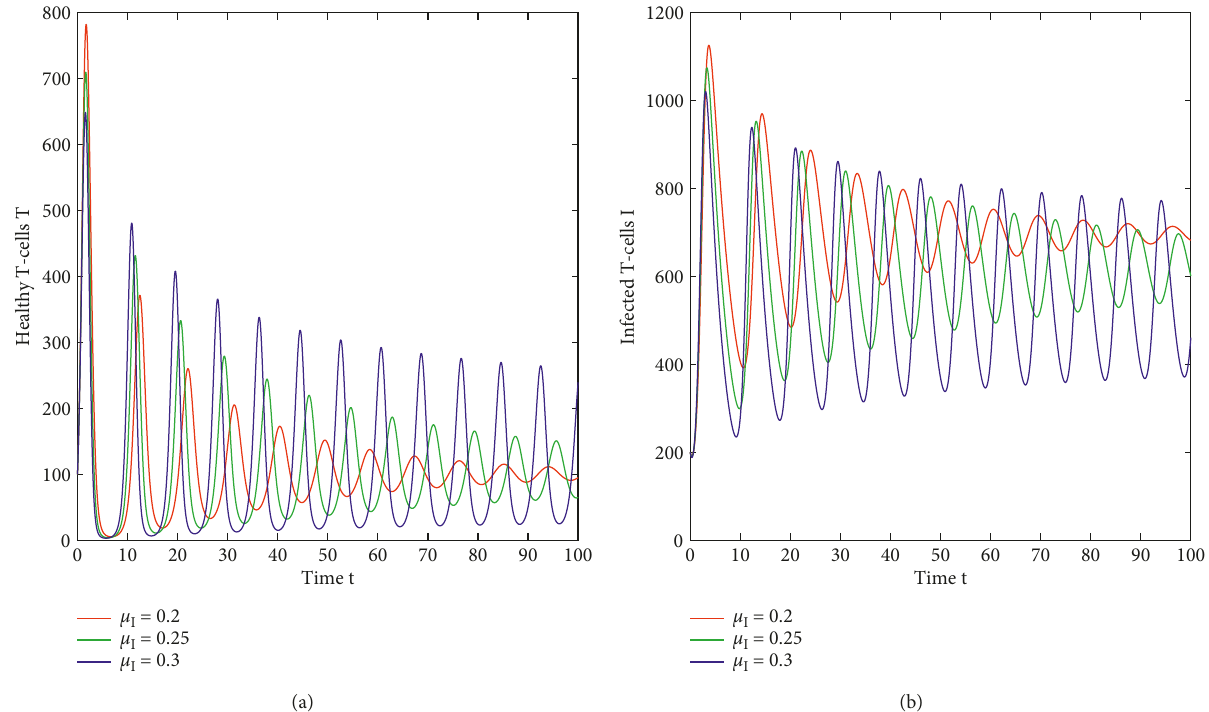
Figure 11: Illustration of the time series of the suggested fractional model (2) of HIV with the variation of μ